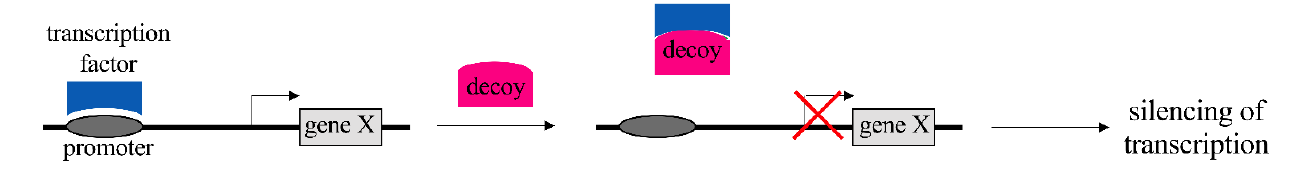
Figure 5. Representation of the mechanism of action of decoys.